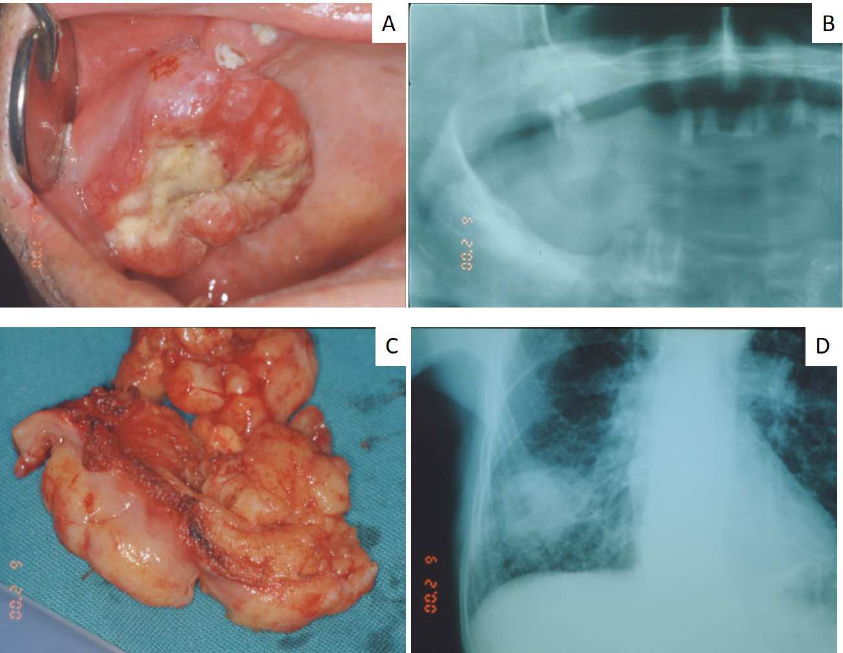
Figure 2. Wide ulcerated lesion of the adherent maxillary gingiva extended to the palate and the cheek mucosa ( A ), associated with a residual decayed dental root ( B ); the lesion was removed ( C ) to improve function and finally resulted as the first manifestation of an unknown non-small cell lung carcinoma ( D ).